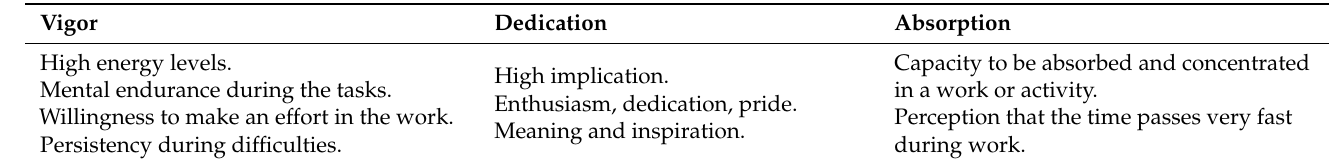
Table 1. Engagement Components